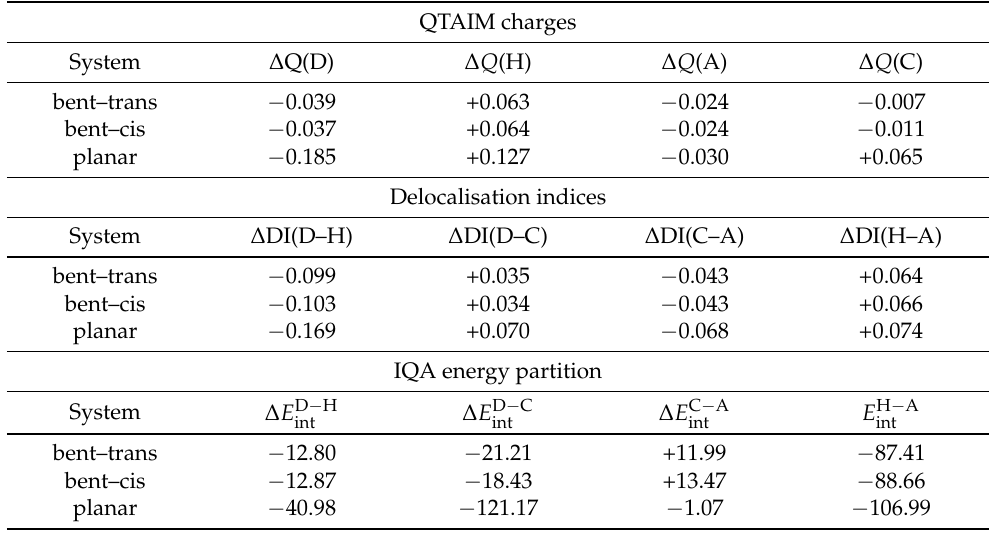
Table 6. Change in the QTAIM charges and electron delocalisation indices, in atomic units, upon the formation of the different AZH (DCR) dimers. Some selected changes of IQA interaction energies (in kcal/mol) are reported as